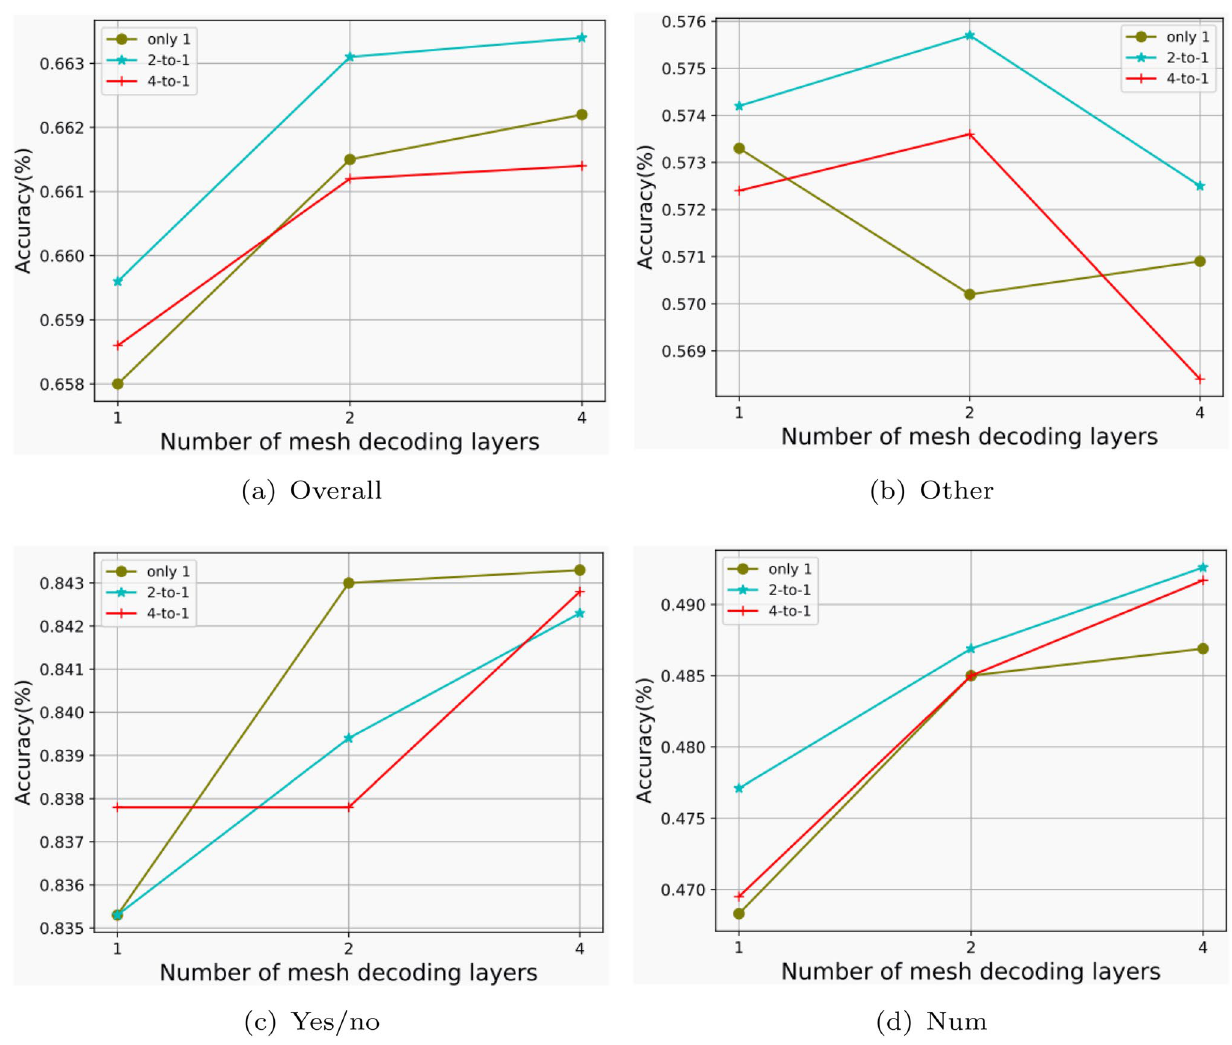
ing questions “Other”. “Overall” represents the overall model accu- racy. The question features are connected in three ways: “only-1”, “2-to-1” and “4-to-1”. The number of decoding layers is 1, 2, and 4, respectively